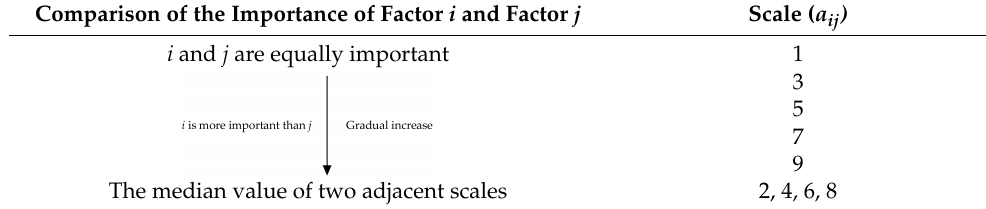
Comparison of the Importance of Factor i and Factor